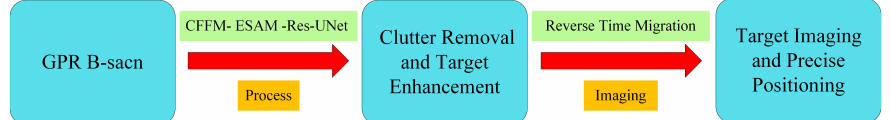
Figure 7. Comprehensive workflow for precisely identifying subterranean anomalies via GPR data analysis.